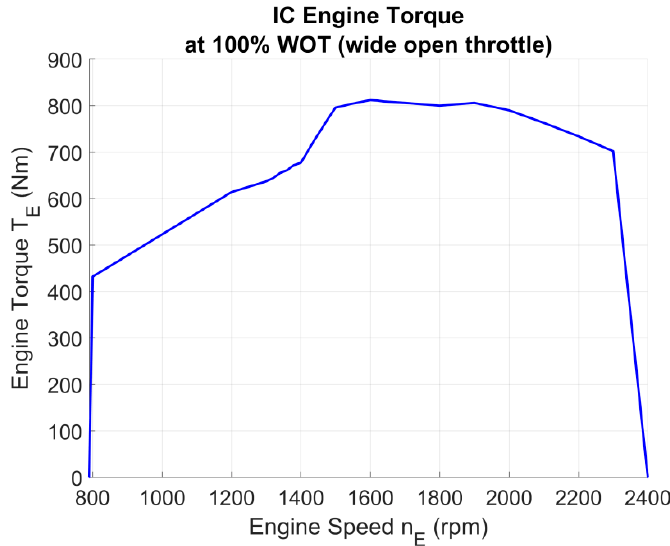
Figure 4. Internal combustion (IC) engine torque curve at 100% wide open throttle.